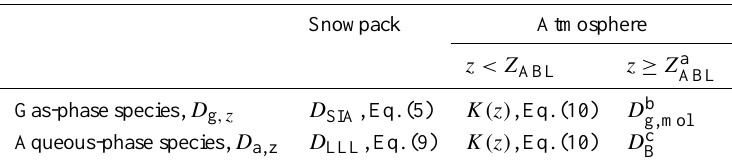
Table 1. Parameterizations used for the vertical diffusivity of gaseous and aqueous-phase (atmospheric aerosols and snowpack LLL) com- position in different model